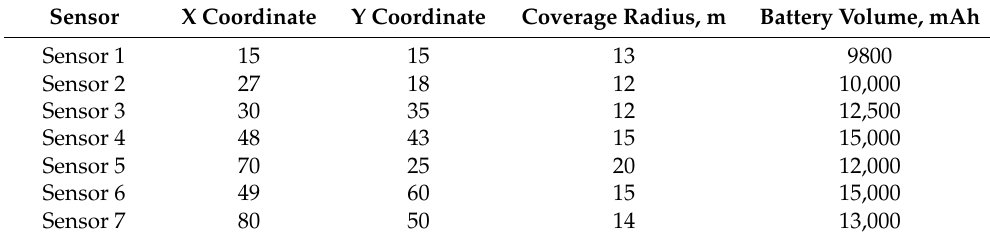
Table 2. Input sensor network